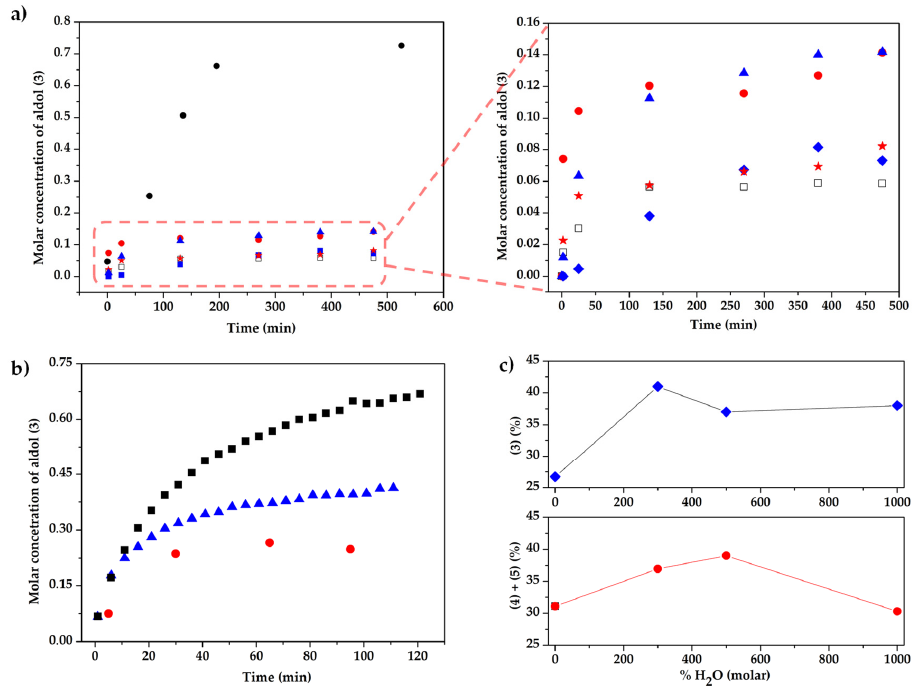
Figure 5. ( a ) Evolution of the concentration of the aldol product ( 3 ) with time for the different systems studied in DMSO-d 6 (aldehyde( 1 ):ketone( 2 ) = 1:10) Catalytic systems: L -proline ( (cid:70) ); [BMIM][ L -Pro] ( (cid:3) ); ( ± )- trans -Cy6-OH-Im-Bu- L -Pro ( (cid:7) ); ( S , S )- trans -Cy6-OH-Im-Bu- L -Pro ( • ); ( R , R )- trans -Cy6-OAc-Im-Bu- L -Pro ( (cid:78) ); inset: L -Pro:( R , R )- trans -Cy6-OAc-Im-Bu-Cl (1:4) ( ). ( b ) Evolution of the concentration of 3 with time for the reaction catalyzed by [BMIM][ L -Pro] in DMSO-d 6 under